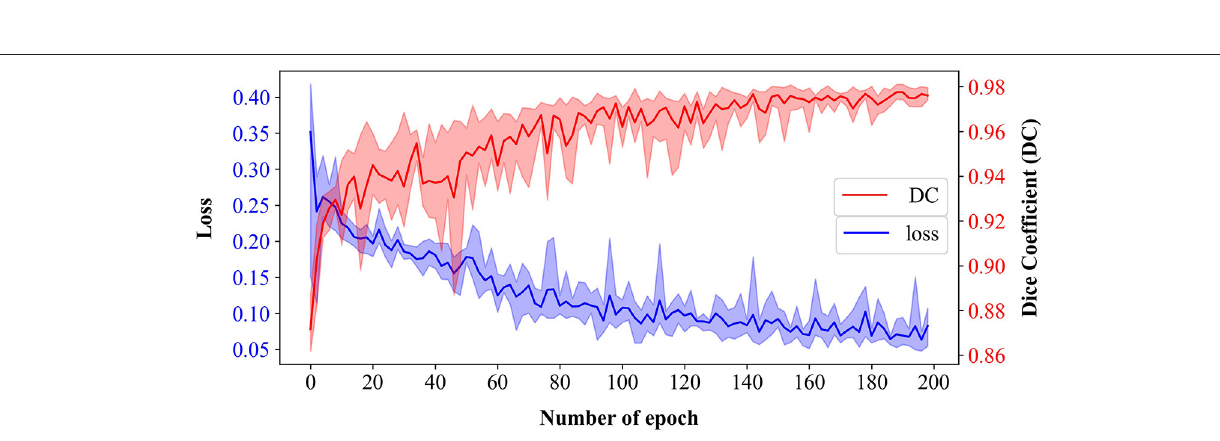
Frontiers in Plant Science |